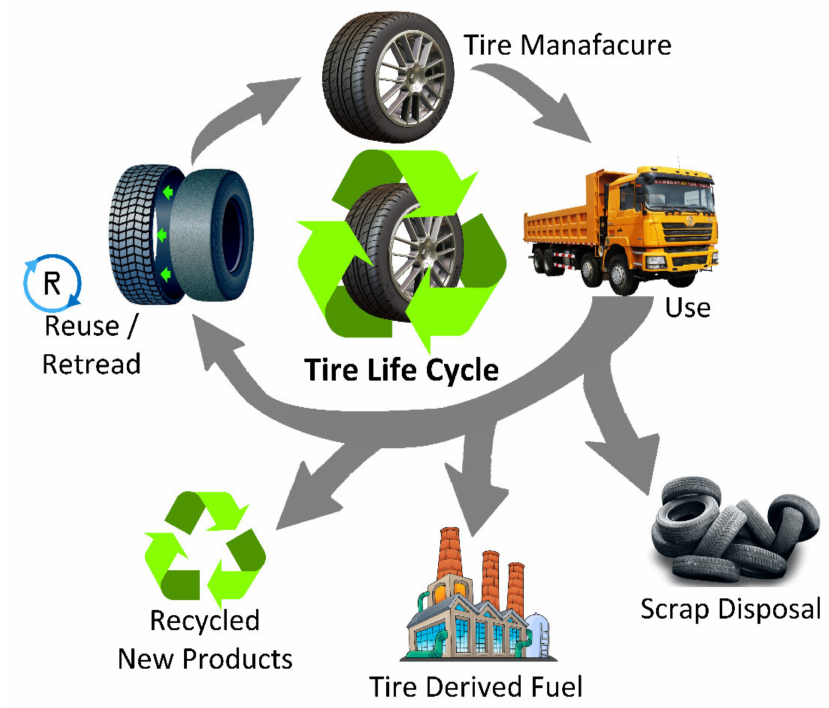
Figure 4. Life cycle of a